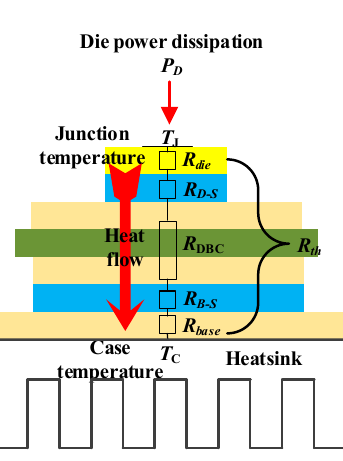
Figure 3. Thermal network in healthy module.